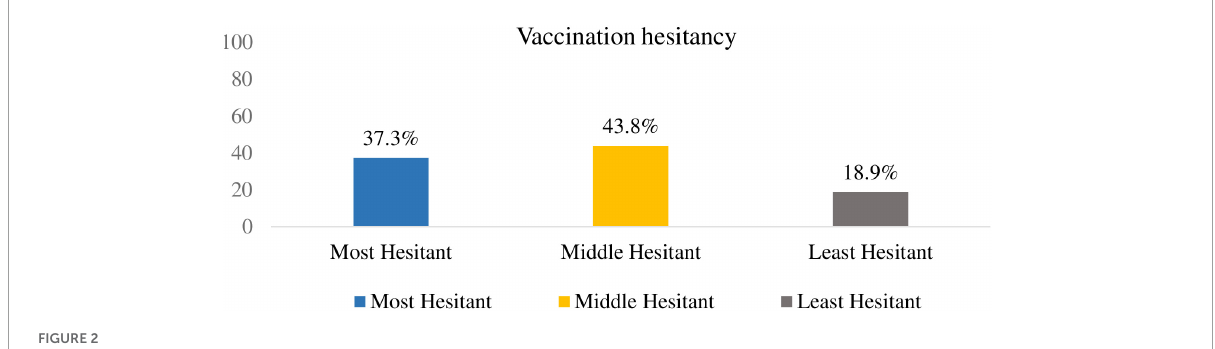
FIGURE2 Vaccination hesitancy among mothers/caregivers.